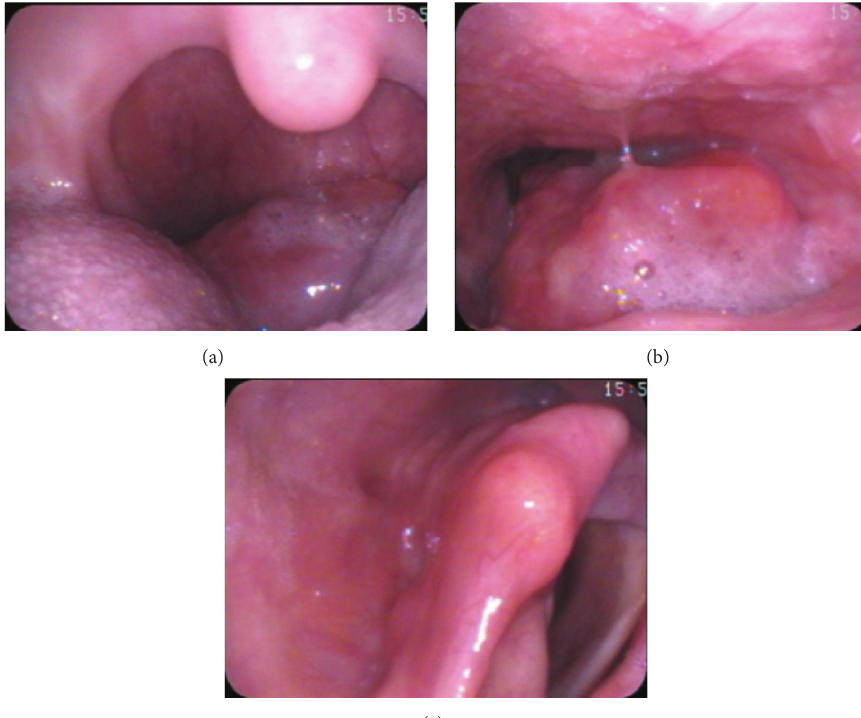
Figure 2: Direct visualization of the mass through mouth (a) and flexible fiberoptic laryngoscopy shows the mass extending to oropharynx (b), but the glottis was not involved and was visualized when passing the scope around the mass (c). Table 1: Details of the immunostaining and hybridization: immunohistochemistry ∗